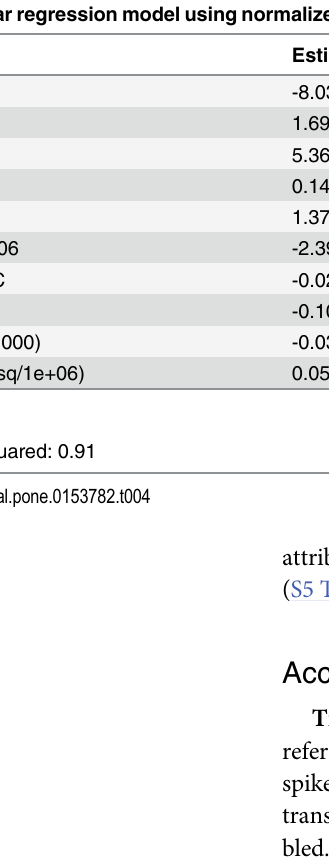
Table 4. Linear regression model using normalized DESeq2-HTSeq FPKM values for single loci spike-ins. Estimate Std. Error